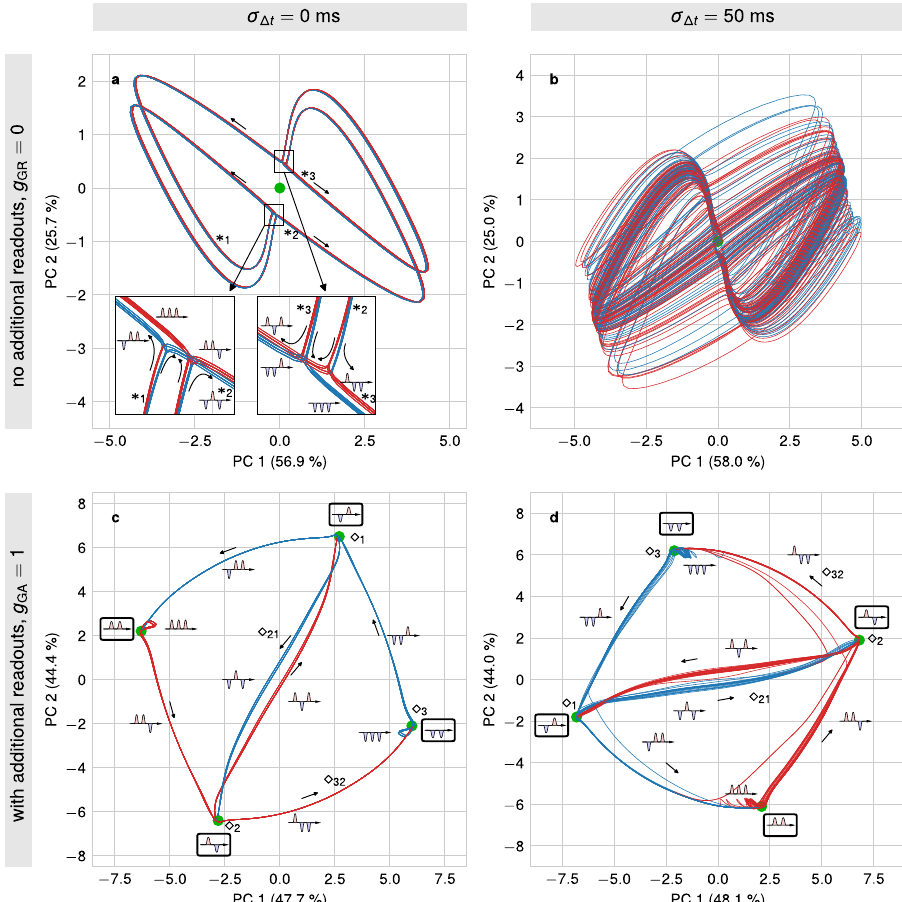
Figure 5. Neural network dynamics during performing the benchmark task projected onto the first two principal components. Trajectory sections which should trigger a positive pulse at the readout units are drawn in red while those which should trigger a negative response are shown in blue. The small arrows indicate the direction in which the system flows along the trajectory. The small pictograms indicate the recent history of the input pulses along the time axis. Green dots indicate attractor states (manually added). ( a ) The network without additional readouts (Fig. 1) stores the history of stimuli on transients. ( b ) By introducing variances in input timings, these transients smear impeding a proper readout. ( c ) The additional readouts (or specially-trained neurons; Fig. 3) “structure” the dynamics of the system by introducing several attractor states each storing the history of the last two stimuli. ( d ) Even in the presence of timing variances the attractor-dominated structure in phase space is preserved enabling a proper readout. Parameters: mean inter-pulse interval μ Δ t = 100 ms; ( a ) g GR = 0, σ Δ t = 0 ms; ( b ) g GR = 0, σ Δ t = 50 ms; ( c ) g GA = 1, σ Δ t = 0 ms; ( d ) g GA = 1, σ Δ t = 50 ms. Details see Supplementary Discussion